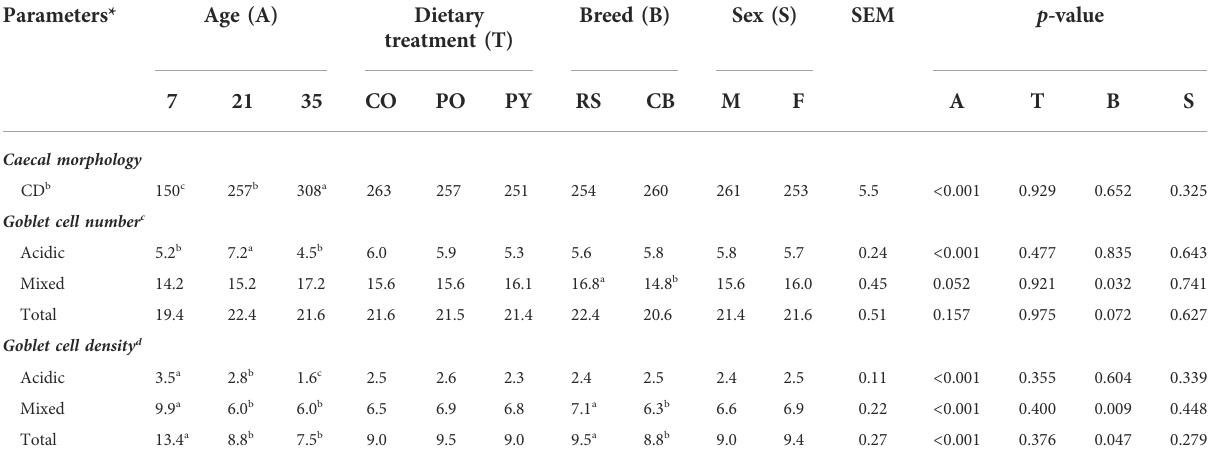
TABLE 3 The effect of age, dietary treatment, breed and sex on histomorphology in the caecum of broilers a . Parameters* Age (A)